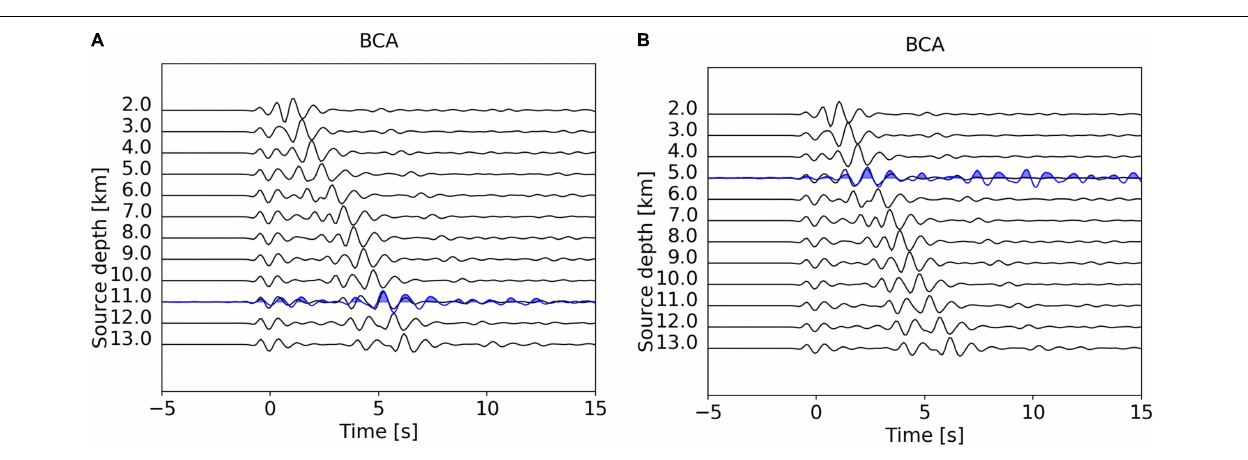
FIGURE 8 | (A,B) Modeled teleseismic depth phases for the BCA array for different assumed source depth and fixed source mechanism (black lines). For the modeling of the source side crust, we use the velocity model (see Supplementary Figure 5 and Table 1 ) which we have obtained using PyVelest. Stacked array beams (blue lines) are seen consistent with synthetics for a depth of 11 and 5 km in the case of the M w 5.5 2017 earthquake (A) and the M w 5.1 2018 earthquake (B) ,